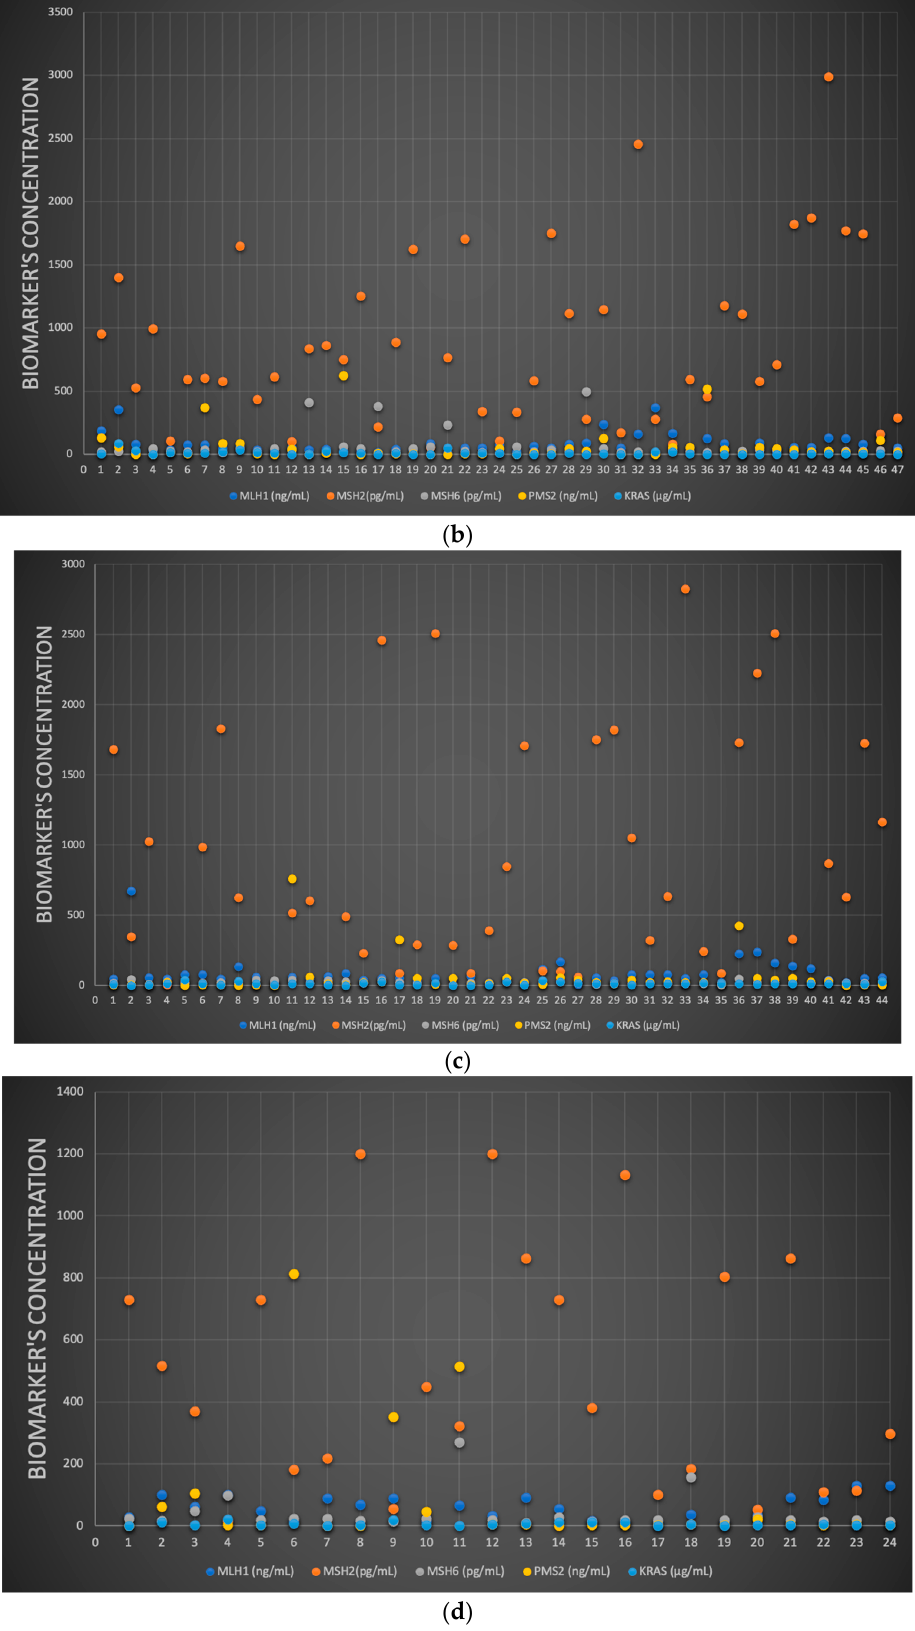
Figure 8. The results of the screening tests of ( a ) whole blood, ( b ) urine, ( c ) saliva and ( d ) tumoral tissue samples using the stochastic sensors based on MD/EGR-2.